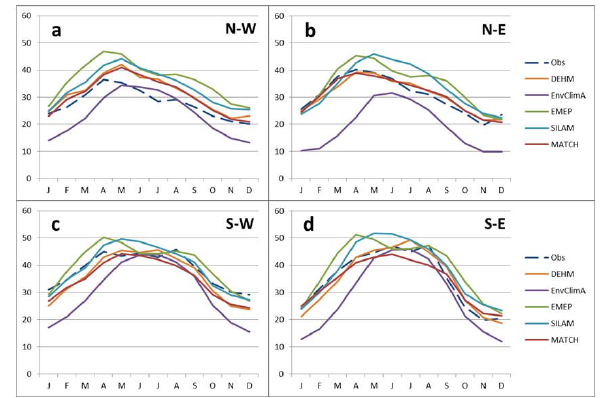
Fig. 5. Model simulated and observed seasonal cycle of monthly average surface O 3 concentrations for each quadrant of the simula- tion domain. Observations are averages for the period 1997–2003 and for stations indicated in Figure 6. The number of stations in each quadrant is (a) 24, (b) 26, (c) 14 and (d) 17. Model results are for the reference period, 2000–2009, using meteorology from each CTM’s driving climate model (ECHAM5 A1B-r3, ECHAM5 A1B- r3 and 3×ECHAM5 A1B-r3-RCA3), and are from lowest model layer, ca. 25–45 m height. Unitsppb(v).